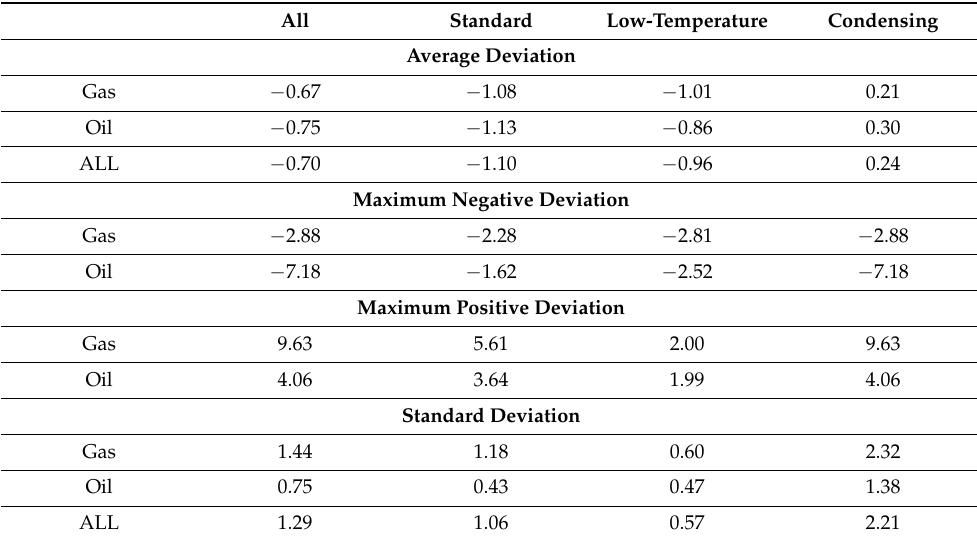
Table A2. Deviation between simplified and detailed calculations and water heater efficiency for